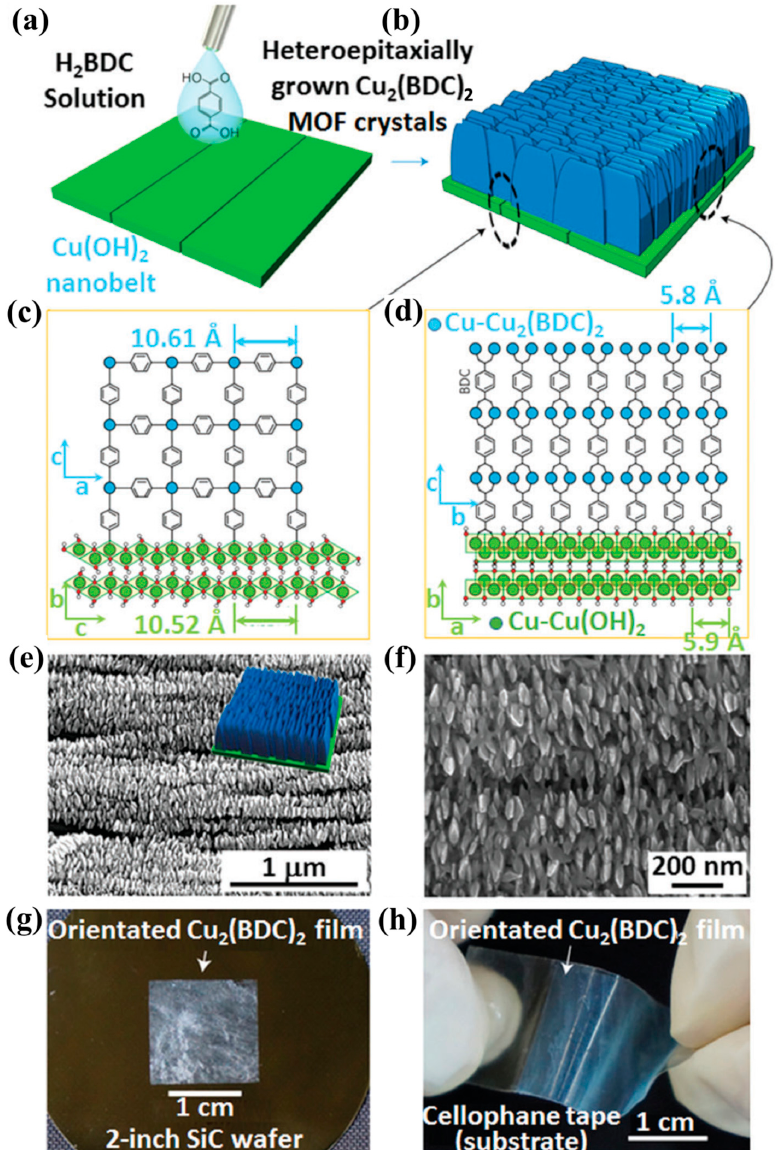
Figure 7. Substrate-seeded heteroepitaxial growth of the Cu 2 (BDC) 2 film on oriented